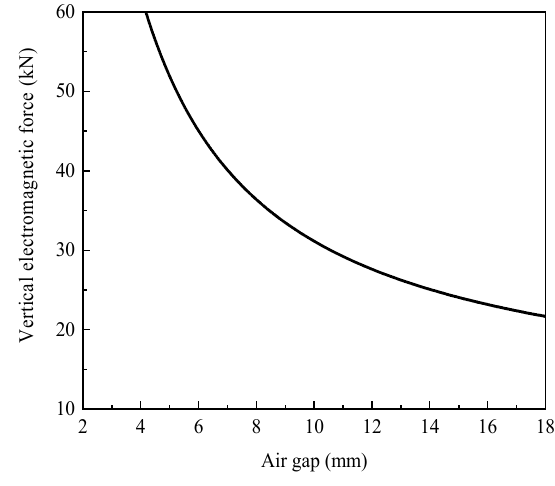
Figure 9. Electromagnetic force curve [15].